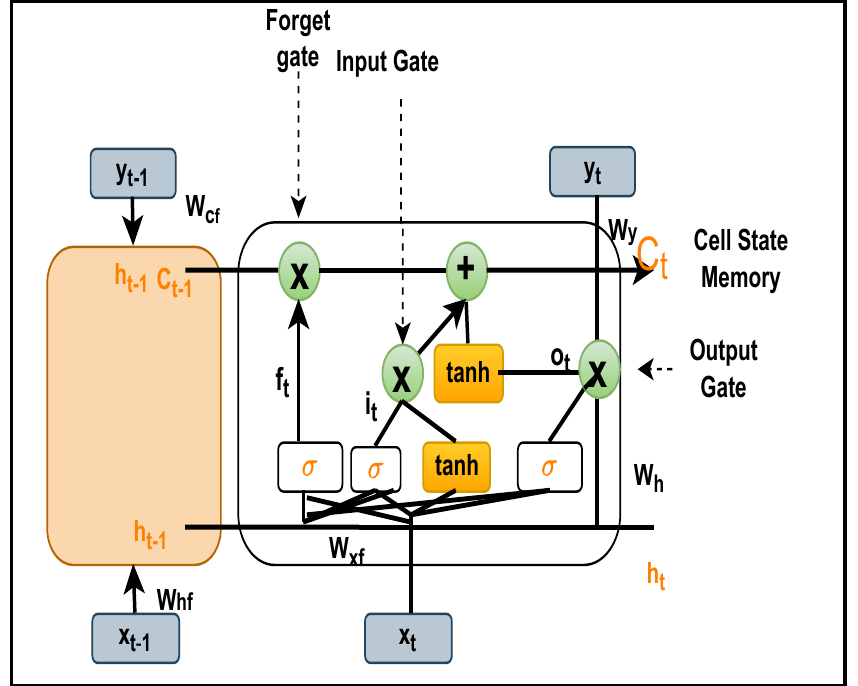
Figure 7. Complete representation of Long Short Term Memory